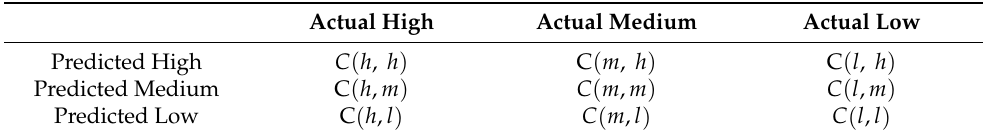
Table 1. Asymmetric misclassification cost